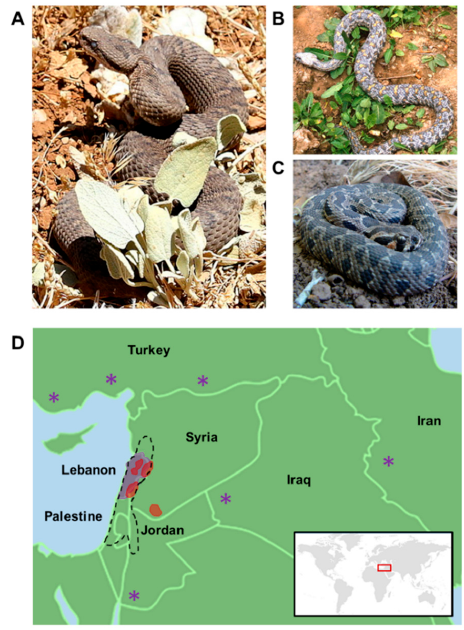
Figure 1. Main vipers of the Middle East region. Photos of ( A ) Montivipera bornmuelleri captured by Mickey Samuni-Blank © , ( B ) Macrovipera lebetina captured by Jan Šev č ík © , and ( C ) Vipera ( Daboia) palaestinae captured by Guy Haimovitch © . ( D ) Geographic distribution of Montivipera bornmuelleri (in red), Macrovipera lebetina (in magenta), and Vipera ( Daboia) palaestinae (in black). Montivipera bornmuelleri is present in Lebanon, Syria, and Palestine (red sector). Macrovipera lebetina is very common in Lebanon (magenta sector), but rare in Jordan, Iraq, Iran, and Turkey (magenta asterisks). Subspecies of Macrovipera lebetina can also be found in Tunisia, Cyprus, and Algeria. Vipera ( Daboia) palaestinae is mostly found in Lebanon, Syria, Palestine, and Jordan (dashed black sector). Vipers’ distribution was represented based on ‘The IUCN (The International Union for Conservation of Nature) red list of threatened species’ data.